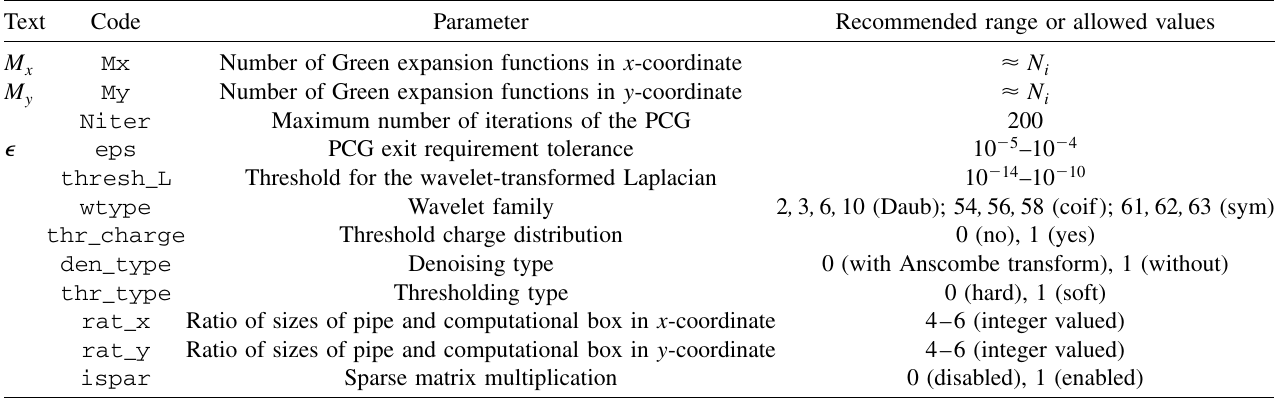
TABLE I. Parameters required for the PCG Poisson equation solver within IMPACT-T .